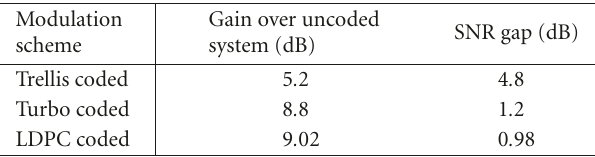
Table 2: Gains achieved with channel coding techniques (using rate-1/2 code and QPSK signaling) when transmitting the SPIHT 512 Lena image using 65,536 symbols. The source compressed 512 (cid:0) coding rate is r s = 0 . 25